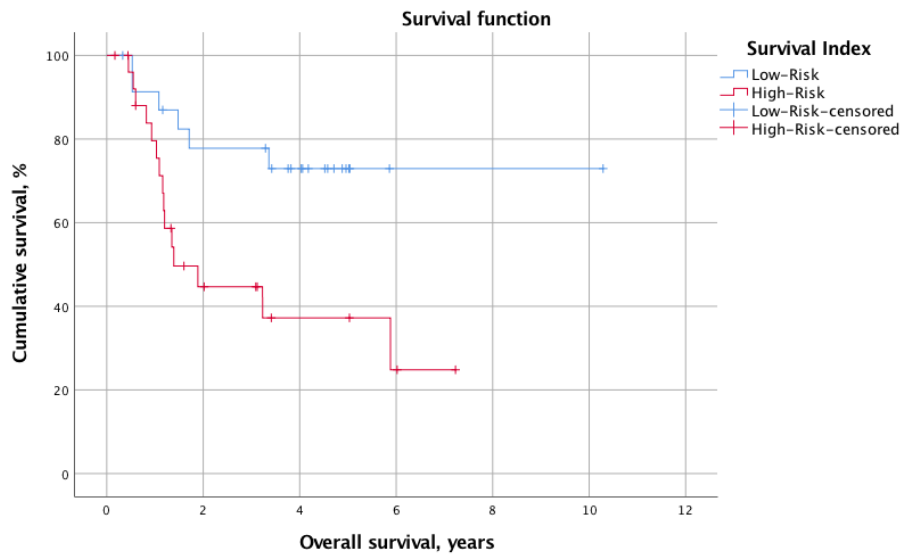
Figure 1. A Kaplan–Meier survival curve showing the OS for patients stratified into the low-SI ( n = 24, SI 0–2) and high-SI ( n = 27, SI 3–6) groups. The mean OS was shorter in the low-risk SI group (mean OS 7.9 years, 95% CI 6.3–9.6 years vs. 3.4 years, 95% CI 2.2–4.5 years). We tested it for statistical significance with the log-rank test, which revealed a significant difference in OS between groups ( p = 0.013). OS, overall survival; SI, survival index; CI, confidence interval.